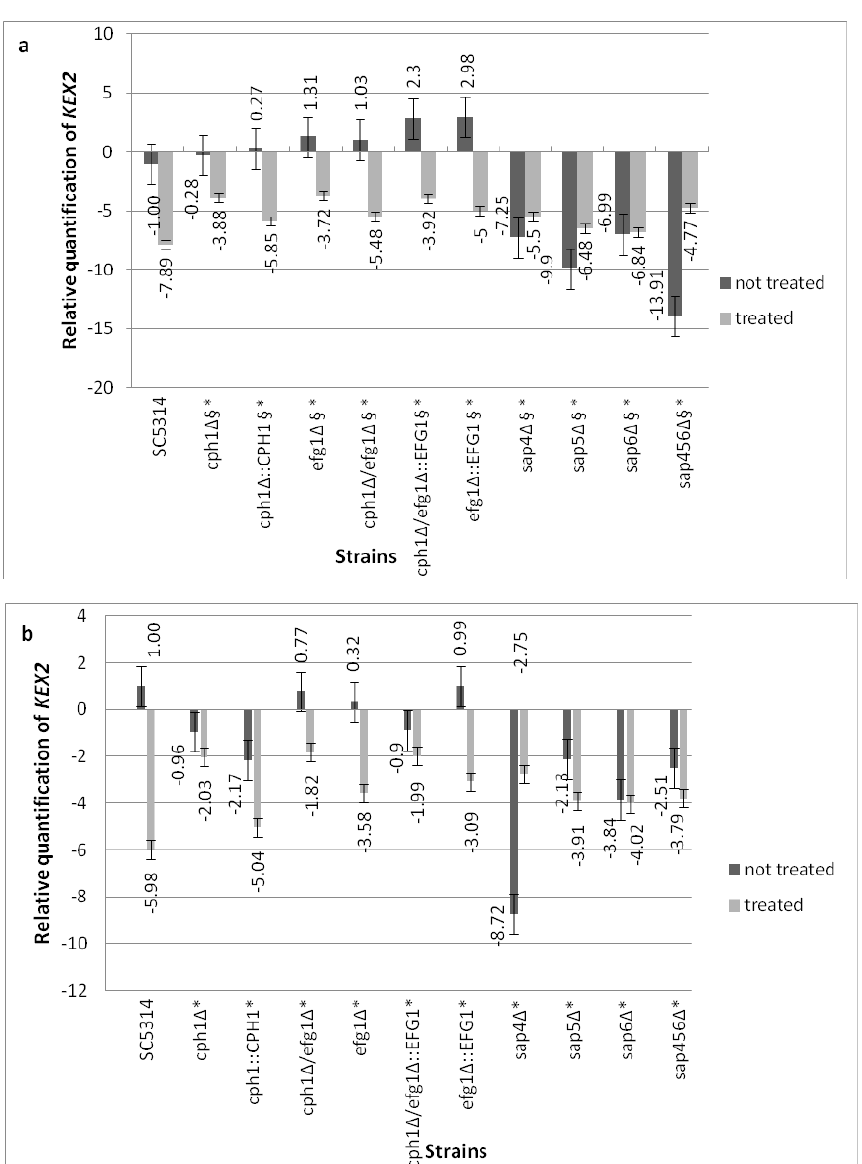
Figure 4. Expression level of KEX2 normalized with the housekeeping gene ACT1 for both the Compound 4 -treated (at 0.25 µg/mL) as well as untreated cells of C. albicans . ( a ) The transcript levels in the C. albicans cells growing in Yeast extract-peptone-dextrose growth YEPD medium; ( b ) The transcript levels in the C. albicans cells growing on Caco-2 cells; Legend: § means statistically significant differences between the untreated and treated cells ( p < 0.05); * means statistically significant differences between SC5314 and mutants (both treated cells, p < 0.05).